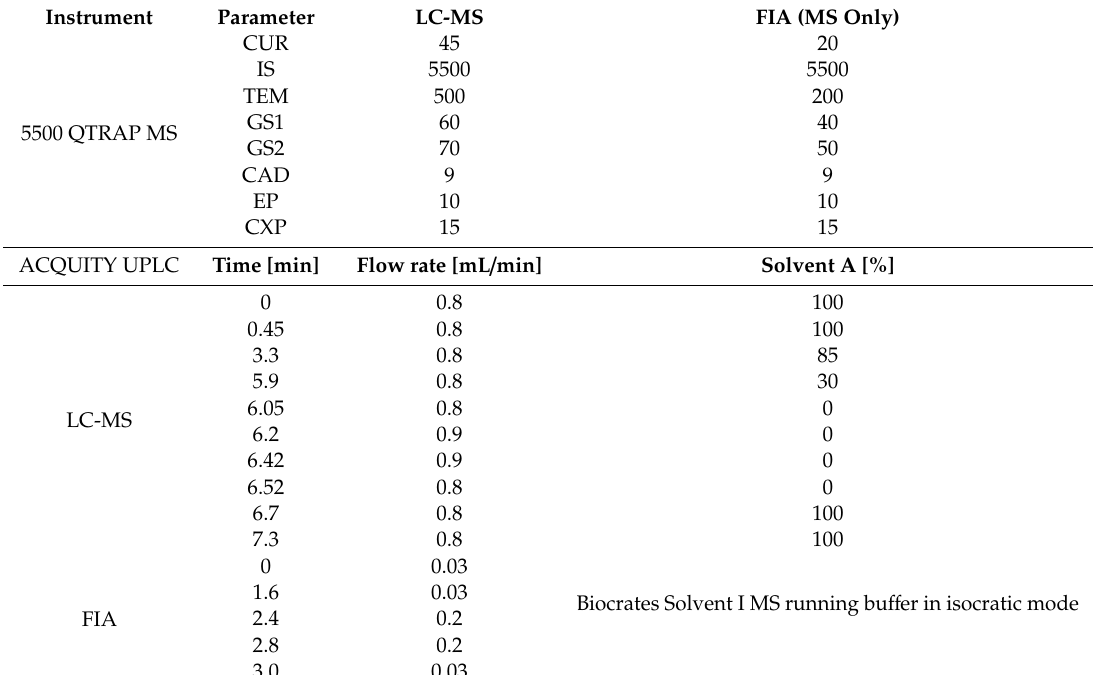
Table 1. LC and MS parameters 1